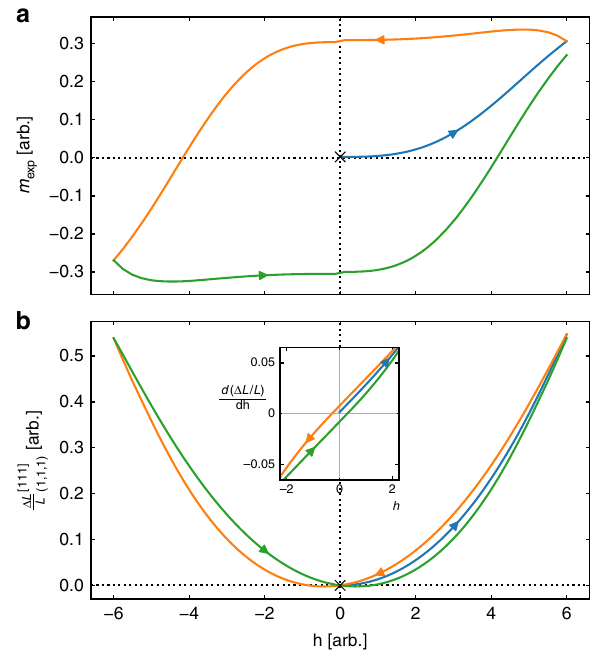
Fig. 2 Hysteresis for h || [111]. a Total octupolar order parameter ( m exp ) versus magnetic fi eld strength ( h ) along [111] direction demonstrating ; T hysteresis for T < T . The initial condition is denoted by ‘ × ’ in Fig. 2a, b. Q O b Length change along (1, 1, 1) direction demonstrating hysteresis, using the solution of ( a ), and taking γ c = 0.8. Inset: Derivative of length change along (1, 1, 1) direction with respect to magnetic fi eld strength ( d ð Δ L = L Þ ) versus dh magnetic fi eld. The linear-in- h scaling of Δ L / L is re fl ected as a constant y - intercept